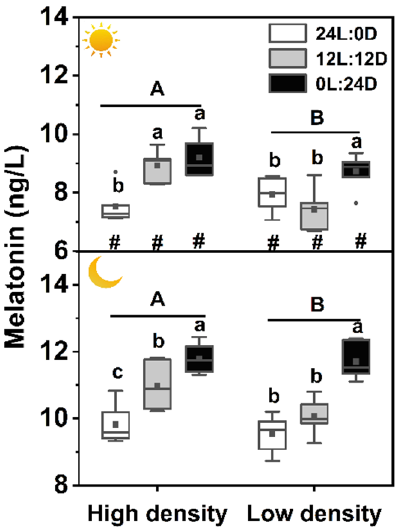
Figure 1. Effects of photoperiod and density on plasma melatonin levels in Pelodiscus sinensis . and indicate daytime and nighttime, respectively. Data are n = 5 or 6 for all groups. Data are presented as the mean ± S.E. In the box plots, the solid horizontal indicates median, the filled square indicates the mean, and points indicate outliers. Different lowercase letters denote statistically significant differences among different photoperiods in each density; different capital letters indicate a significant difference between different densities; # indicate a significant difference between the daytime and nighttime ( p < 0.05). Table 2. Multivariate analysis of variance of photoperiod, time and density on plasma melatonin, food intake and energetic metabolism genes and hormones.